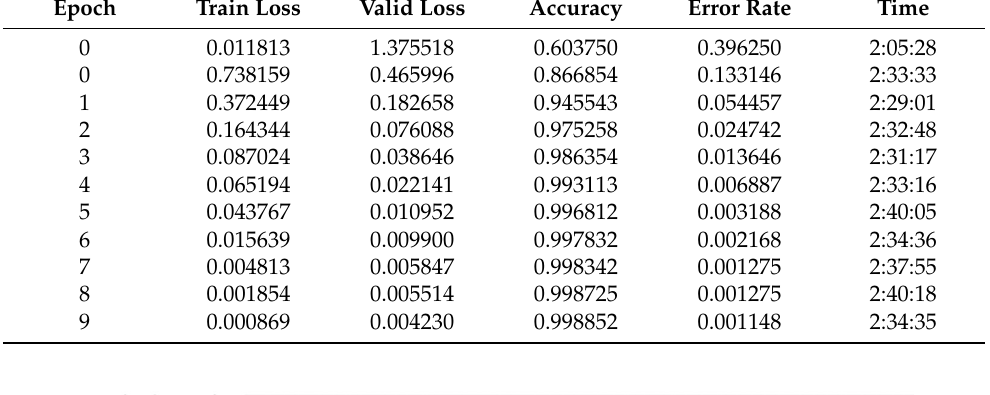
Table 9. Results of the XResNet50.